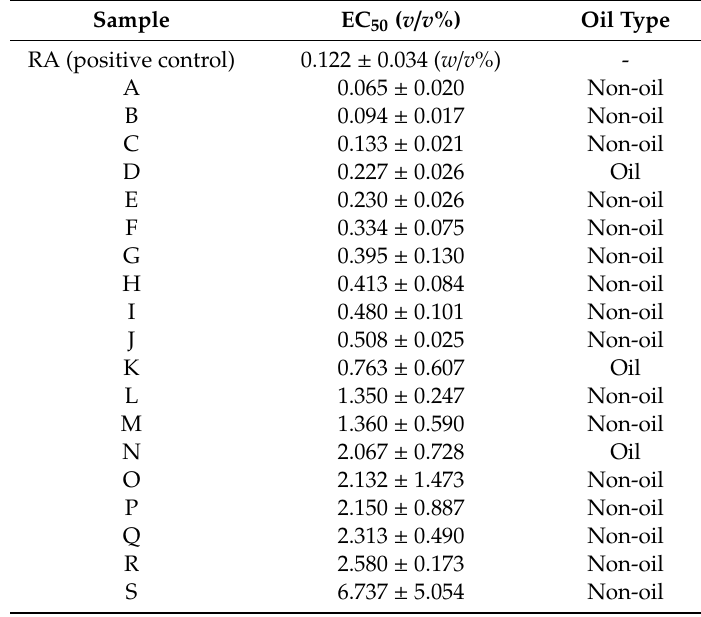
Table 1. EC 50 values of 19 commercial dressing samples using MSHTS